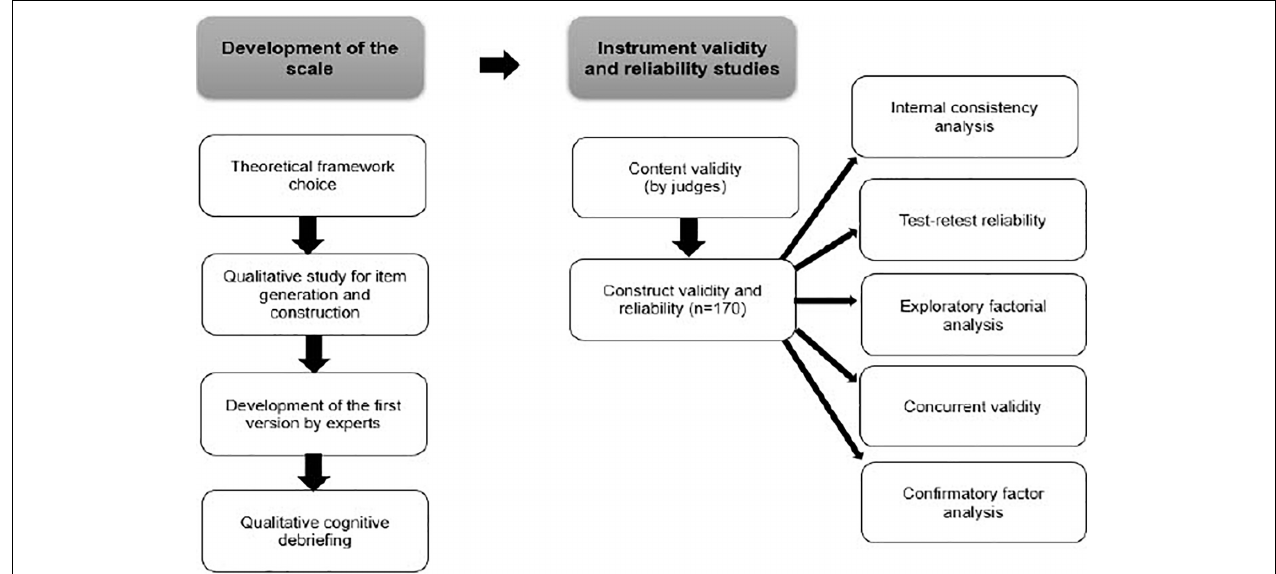
FIGURE 1 | Diagram describing the phases of the study and the ARES